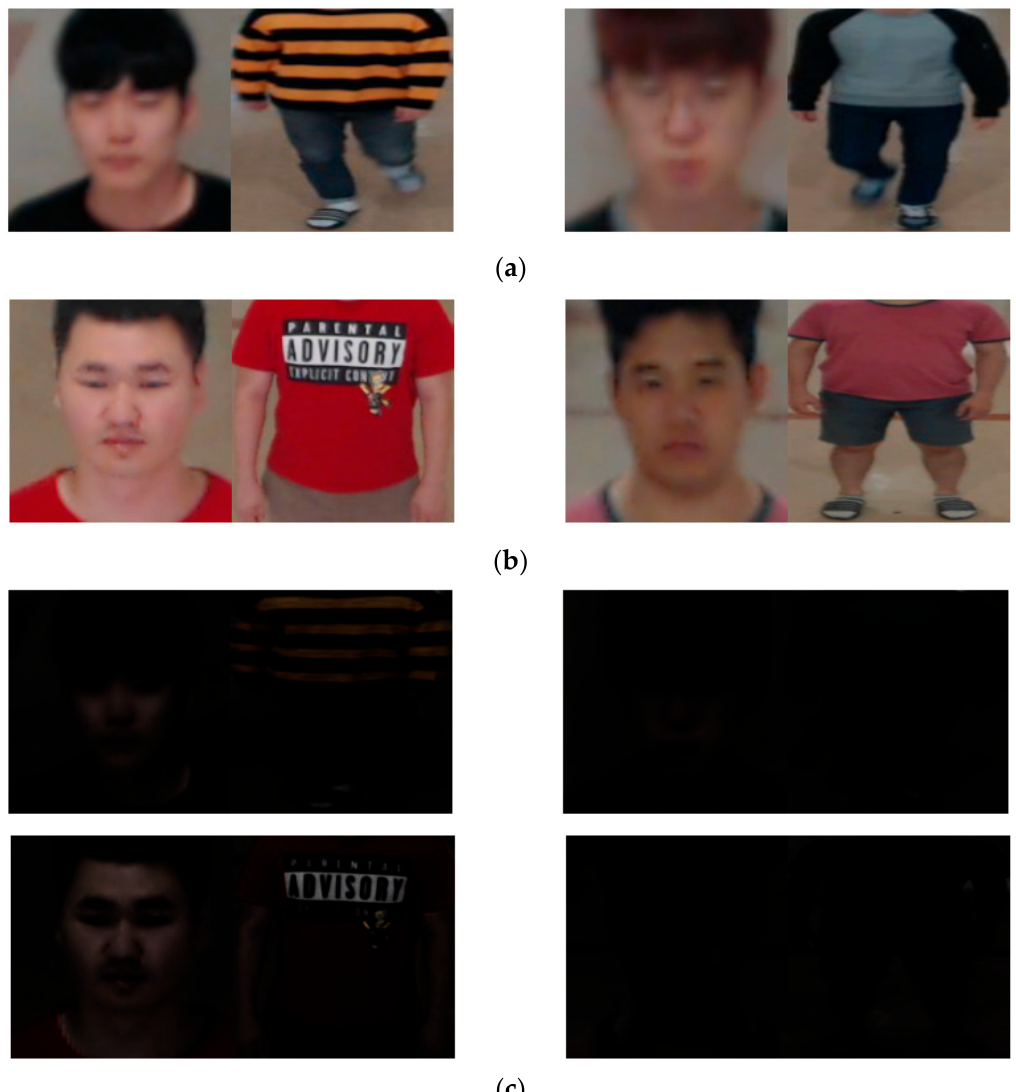
Figure 3. Example of DFB-DB3 figures obtained from ( a ) the Logitech C920 camera and ( b ) the Logitech BCC950 camera. ( c ) Converted low-illumination figure of DFB-DB3.